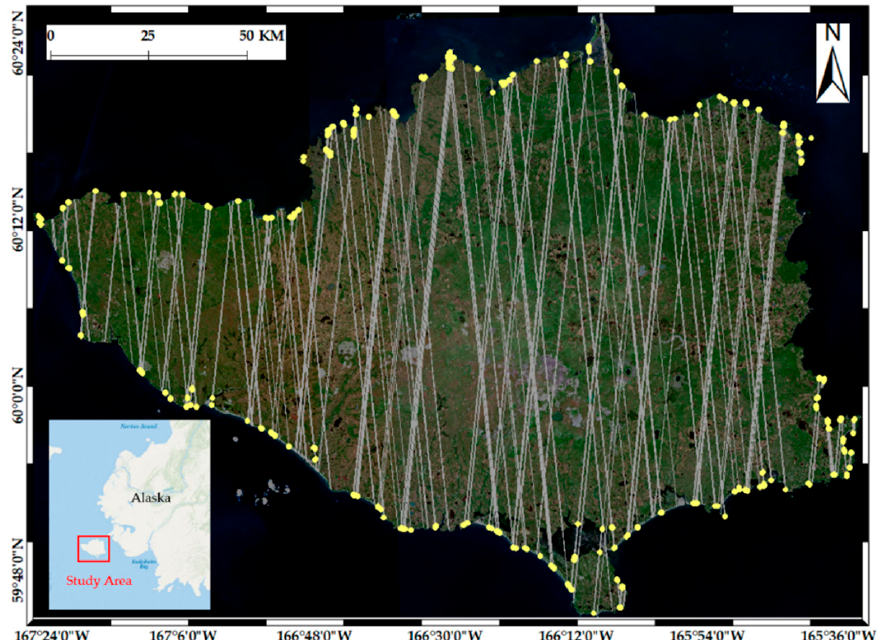
Figure 1. Map of the Nunivak Island, which is near mainland Alaska. The background is a true-color image obtained using the Google Earth Engine and composed using the Sentinel-2 satellite during the summers of 2018 to 2020. The gray lines represent the ICESat-2 trajectory, and ICESat-2 passed through the region starting from 22 October 2018. The yellow areas represent shore zones, which contain ICESat-2 and multispectral data.